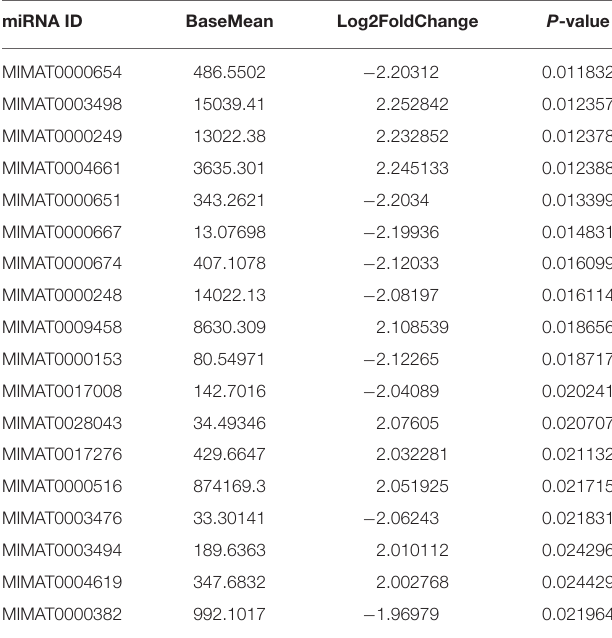
TABLE 3 | Differentially expressed miRNAs between 100 and 10 µ M DEHP treatment. miRNA ID BaseMean